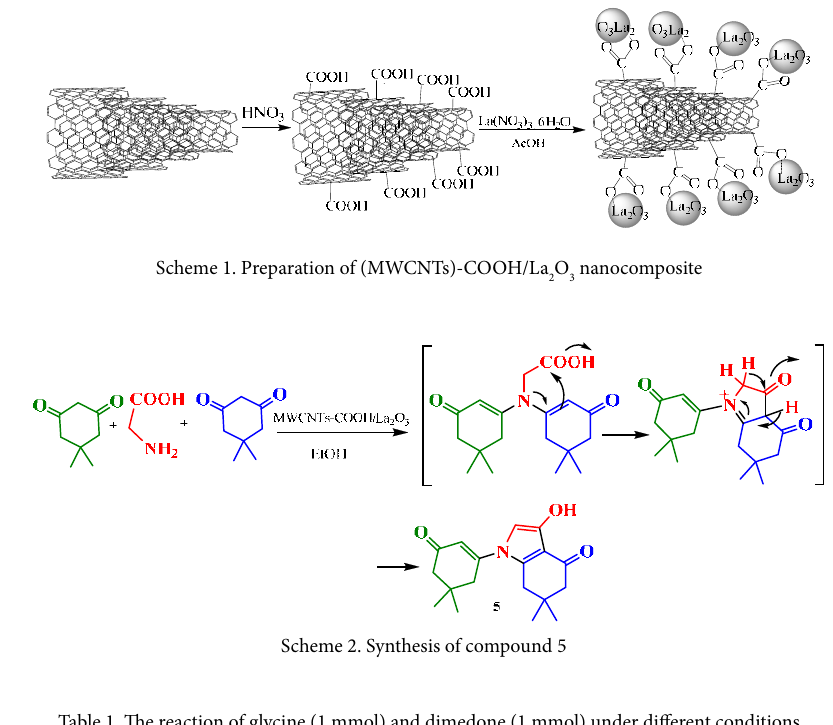
Table 1. The reaction of glycine (1 mmol) and dimedone (1 mmol) under different conditions